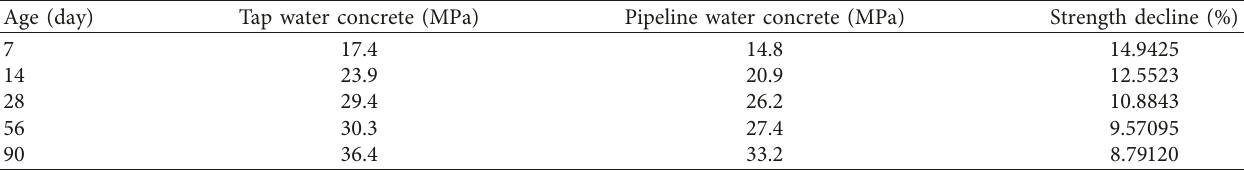
Table 6: The results of the compressive strength test of normal concrete samples made by using tap water and pipeline water. Age (day)